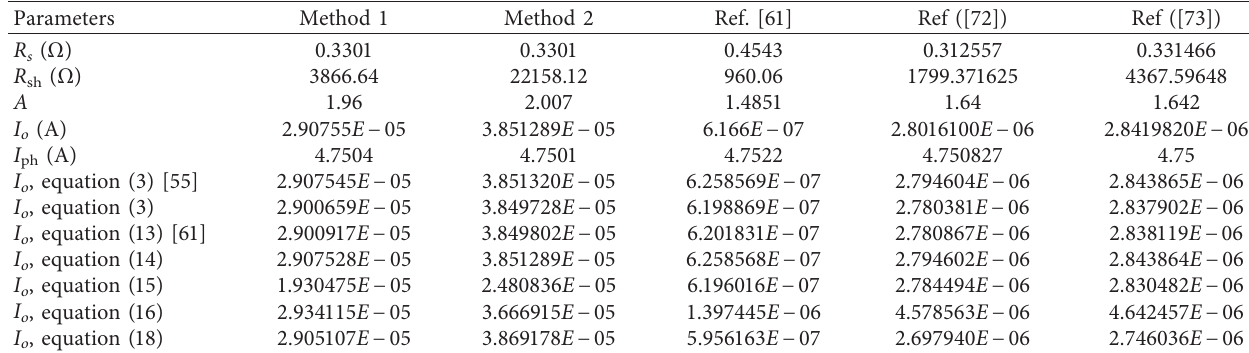
Table 9: Calculated parameters and data from simulations for BP-SX 150.